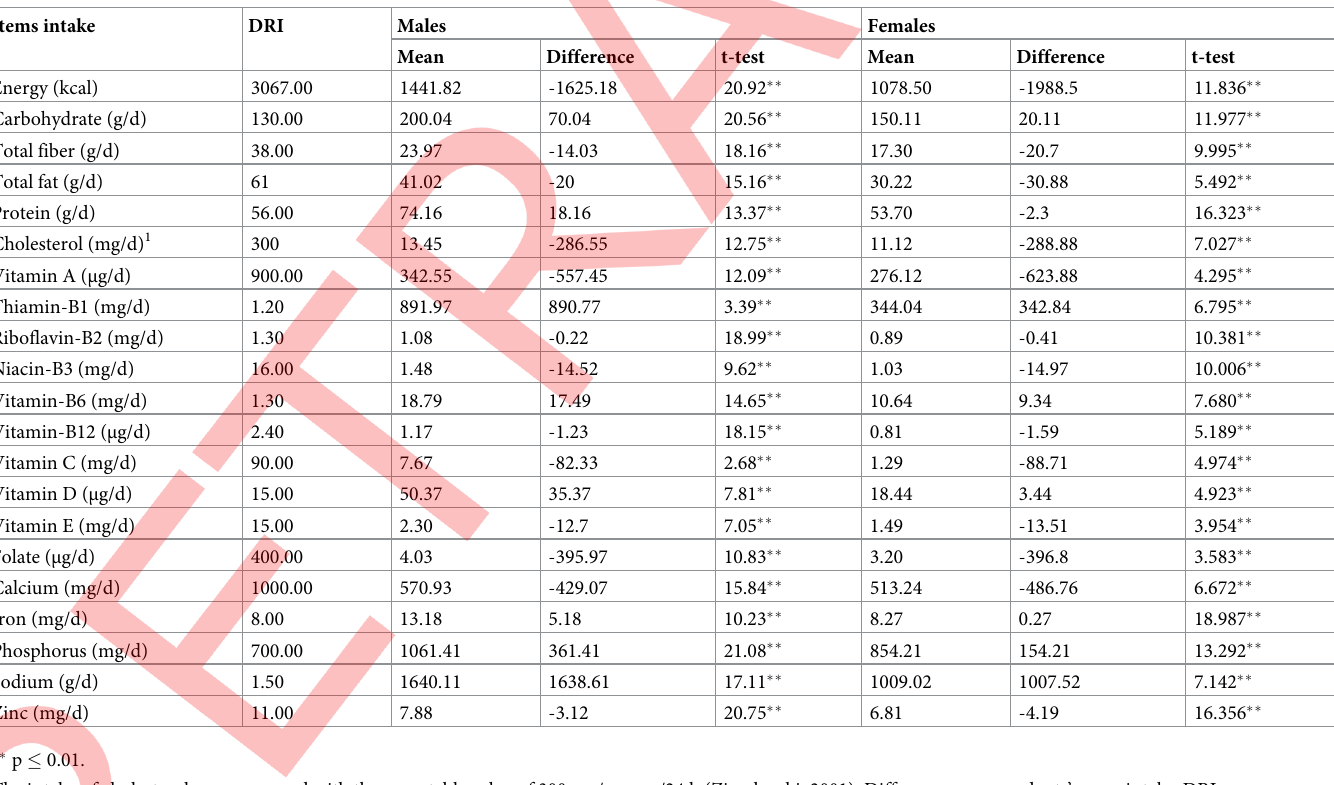
Table 3. Average daily consumption of nutrients (24-h recall) in relation to (DRI) for Yemeni students (male and female) using